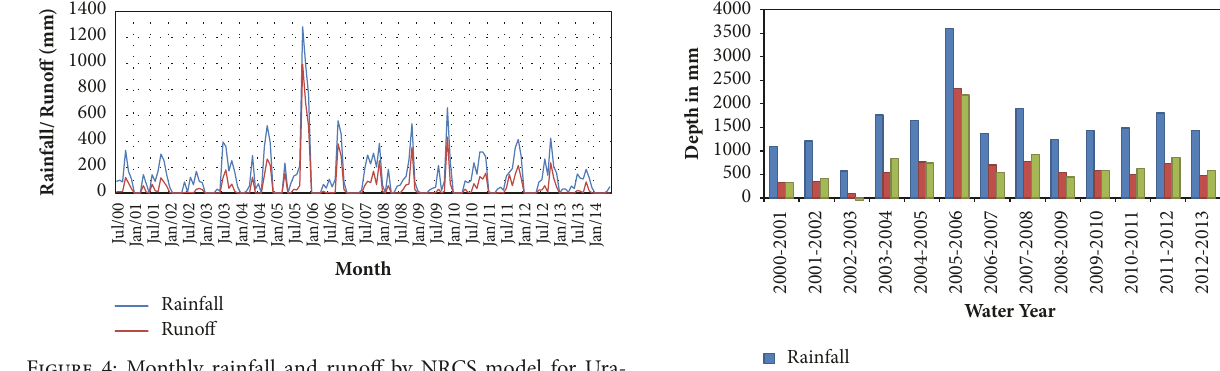
Figure 4: Monthly rainfall and runoff by NRCS model for Ura- pakkam tank watershed. Table 3: Monthly rainfall and runoff for Urapakkam watershed using NRCS model for the water year 2008-2009.